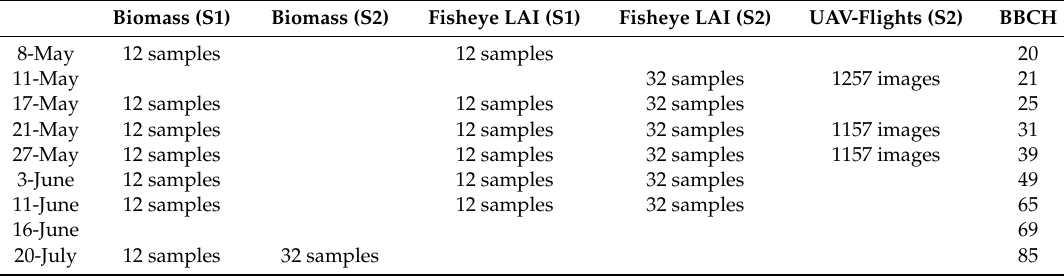
Table 1. The data collection in S1 and